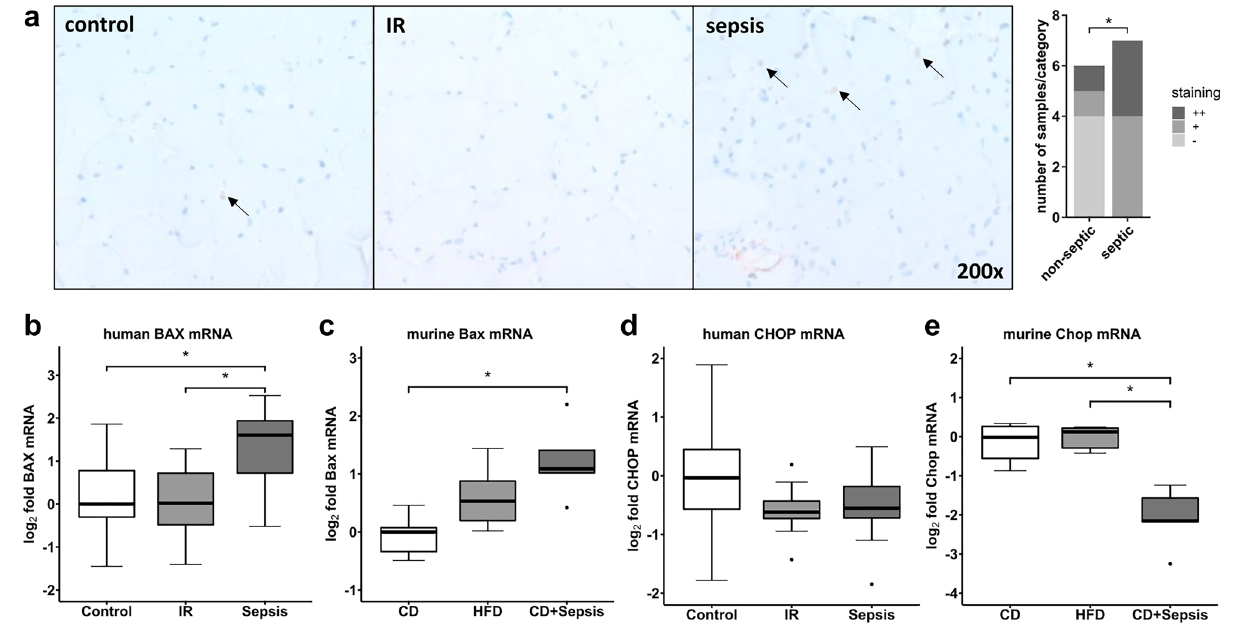
Figure 3. Indicators of apoptosis in skeletal muscle. TUNEL staining and semiquantitative assessment of positive cells ( a ) in human skeletal muscle in sepsis compared to the other groups ( * p < 0.05, χ 2 -test). Arrows indicate TUNEL positive cells (brownish coloring), which are representative for cells undergoing apoptosis. Gene expression analysis for apoptotic marker genes BAX and CHOP, which are related to UPR activation, in human ( b , d ) and murine ( c , e ) skeletal muscle. Data are given as normalized log2-fold changes compared to the median of the respective control groups as reference. Plots for human data represent n = 10 of matched subjects per group (Suppl. Table 2), plots for animal data represent n = 5–6 animals per group. BAX/Bax bcl-2-associated X protein, CD control diet, CHOP/Chop C/EBP homologous protein, HFD high-fat diet, IR insulin resistance, TUNEL TdT-mediated dUTP-biotin nick end labeling; *p < 0.05.